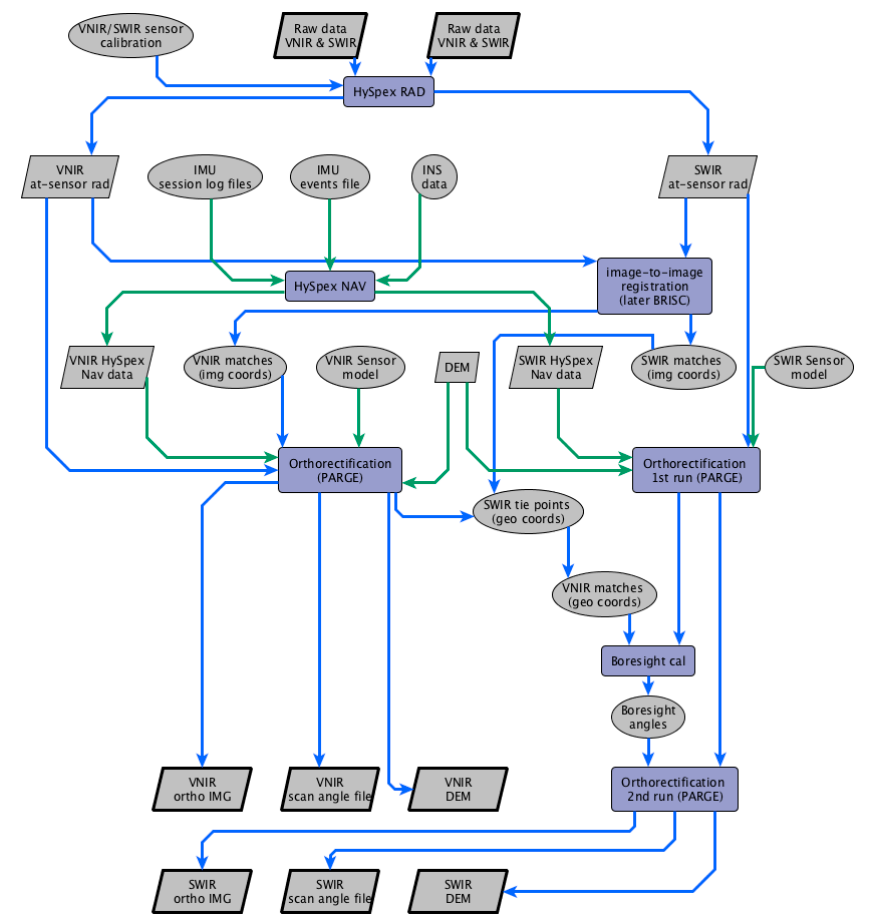
Figure A1. Raw image processing and image orthorectification workflow.